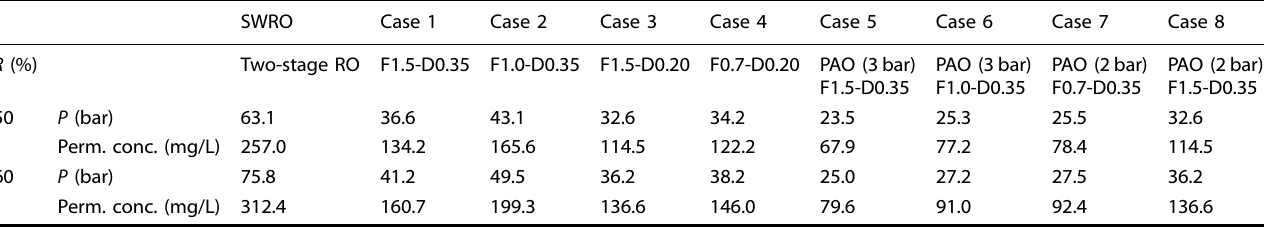
Table 1. Operating pressure and permeate quality of SWRO for different cases (the cases were selected based on the performance test results, with a total of eight cases: four in FO mode and four in PAO mode, using a two-stage RO as the control) and a total plant recovery rate of 60%. SWRO